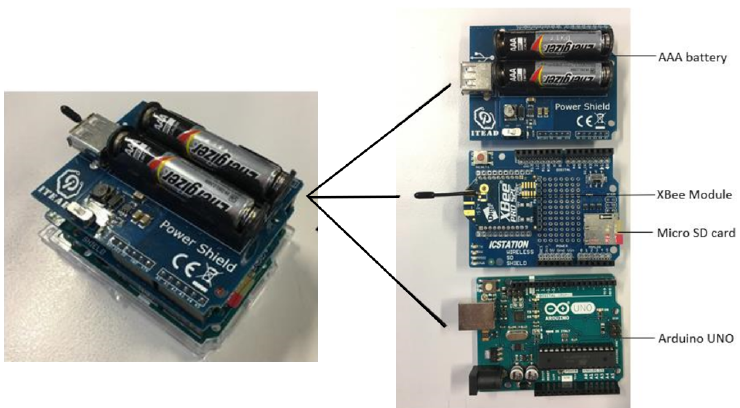
Figure 1. Components of the